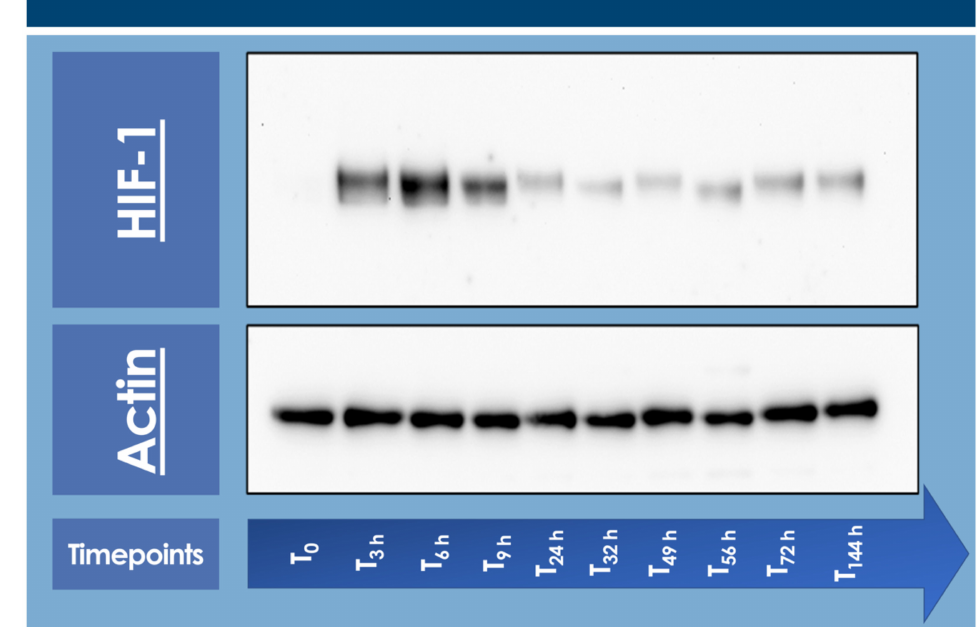
Figure 1. Timecourse specific analysis of HIF-1 α induction upon hFPT (i.e., cells expanded to 80% confluency in normoxia; 5% CO 2 , 21% O 2 ) exposure to hypoxia incubation conditions (i.e., 5% CO 2 , 2% O 2 ). T 0 represents the normoxic culture harvest initial timepoint (i.e., no hypoxic incubation phase). Subsequent timepoints represent hypoxic culture harvests. Whole gel imaging is provided in Supplementary Materials, Figure S1. Quantitative results of relative HIF-1 detection are presented in Supplementary Materials, Table S1. hFPT, human fetal progenitor tenocytes; HIF, hypoxia-inducible